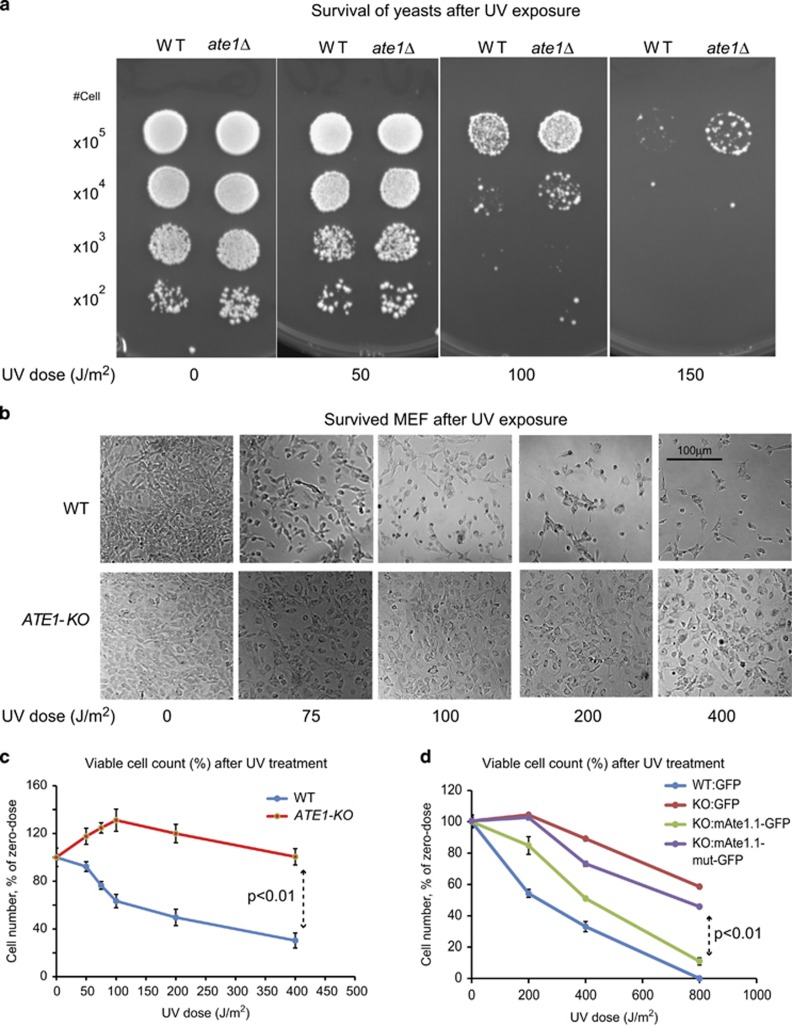
Knockout of ATE1 increases cell viability upon UV irradiation. (a) Representative images of WT and ate1Δ yeast grown for 3 days after exposure to different doses of UV irradiation and recovery in the dark. (b) Representative images showing WT or ATE1-KO MEFs after exposure to increasing doses of UV irradiation and recovery for 24 h. (c) Quantification of viable cells at 12 h after UV treatment. Live cells were quantified with cell viability dye Calcein AM and the numbers were normalized to matching samples not irradiated (0 J/m2). Error bar represents S.E.M. (n=3). (d) Comparison of cell viabilities at 12 h after UV treatment for WT or ATE1-KO cells stably expressing either GFP (as transfection and expression control), mAte1.1-GFP or the catalytically impaired mAte1.1-mut-GFP. The number of viable cells was directly counted by cell counter and using Trypan blue to exclude dead cells